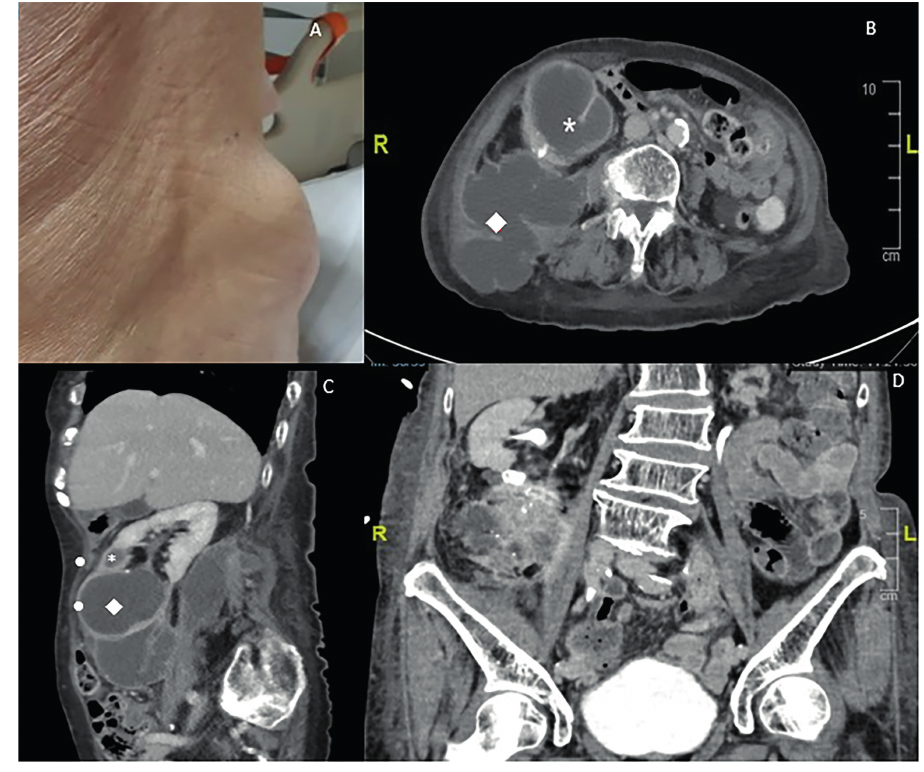
Figure 1 - An 89 year-old female presenting with functional decline and a fall was discovered to have a right flank mass. She underwent CT abdomen and pelvis to evaluate the flank